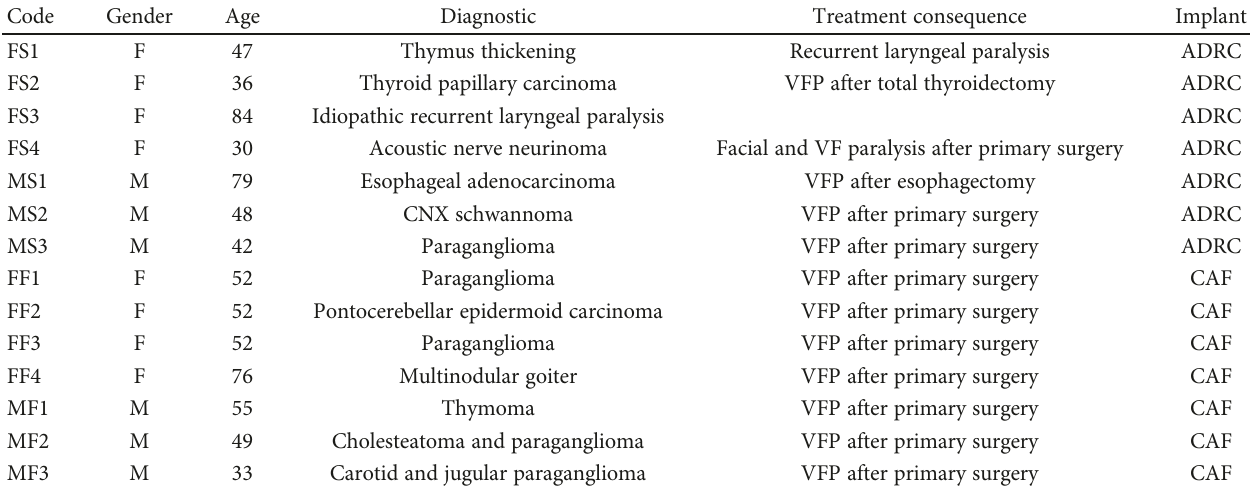
Table 2: List of patients treated in the